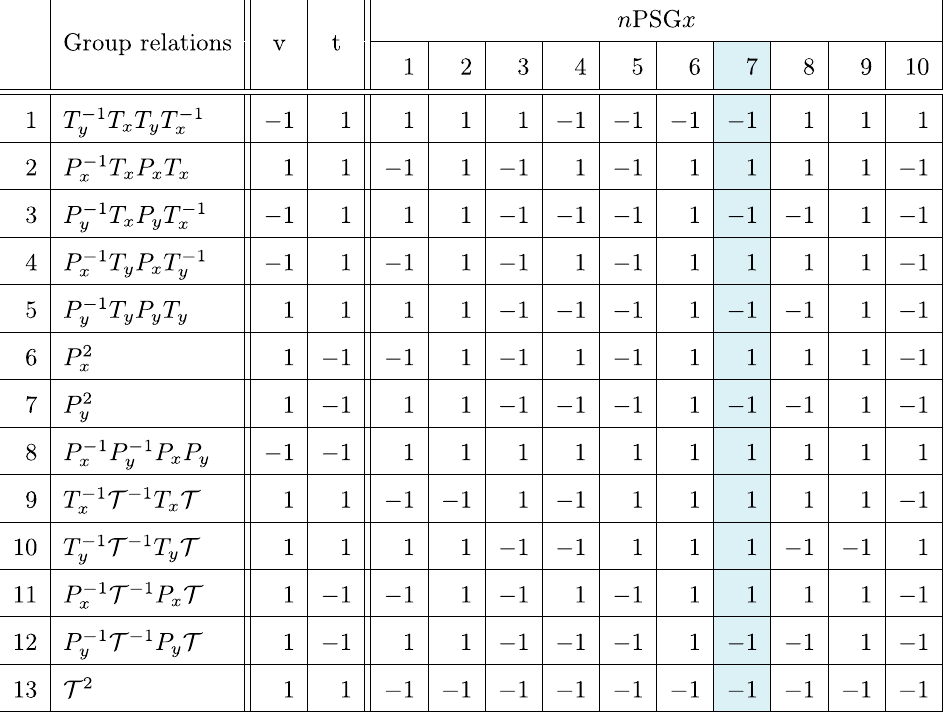
11. Symmetry fractionalization of nematic PSGs ( n PSGs) for spin liquids listed in Fig. 7. n PSG 7 x (highlighted in blue) corresponds to the fermionic PSG determined in Ref. [21]. The columns labeled “ V ” and “ T ” list the vison fractionalization numbers and the twist factors, respectively.